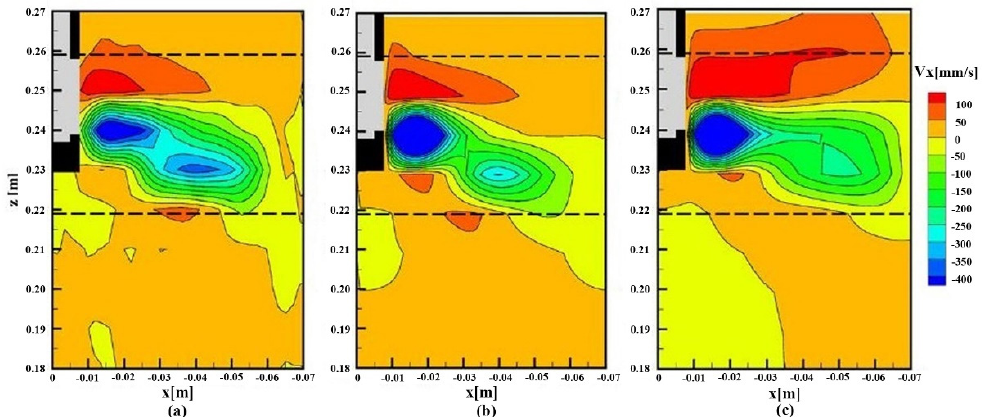
Figure 11. The time-averaged horizontal velocity in the midplane parallel to the mold wide face with electrically conducting mold walls, B0 = 310 mT (within the dotted lines): ( a ) experimental results, ( b ) numerical results from the SST k - ω model + Joule dissipation, ( c ) numerical results from the conventional SST k - ω model [264] (The measured region in Figure 10).